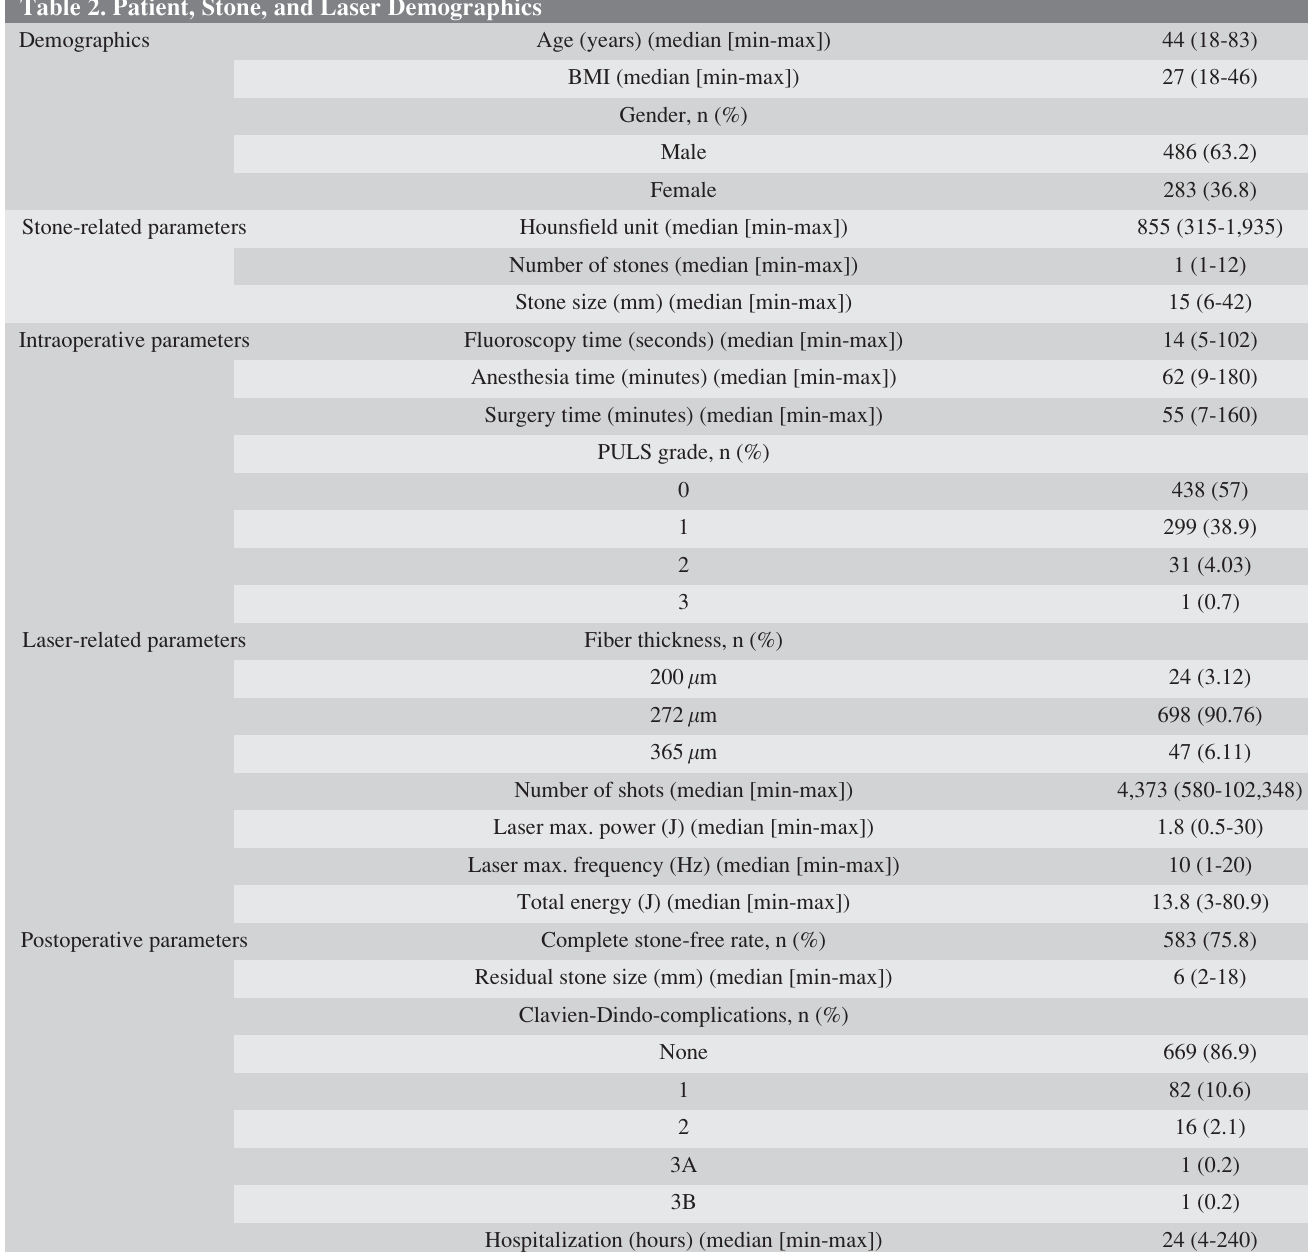
Table 2. Patient, Stone, and Laser Demographics Demographics